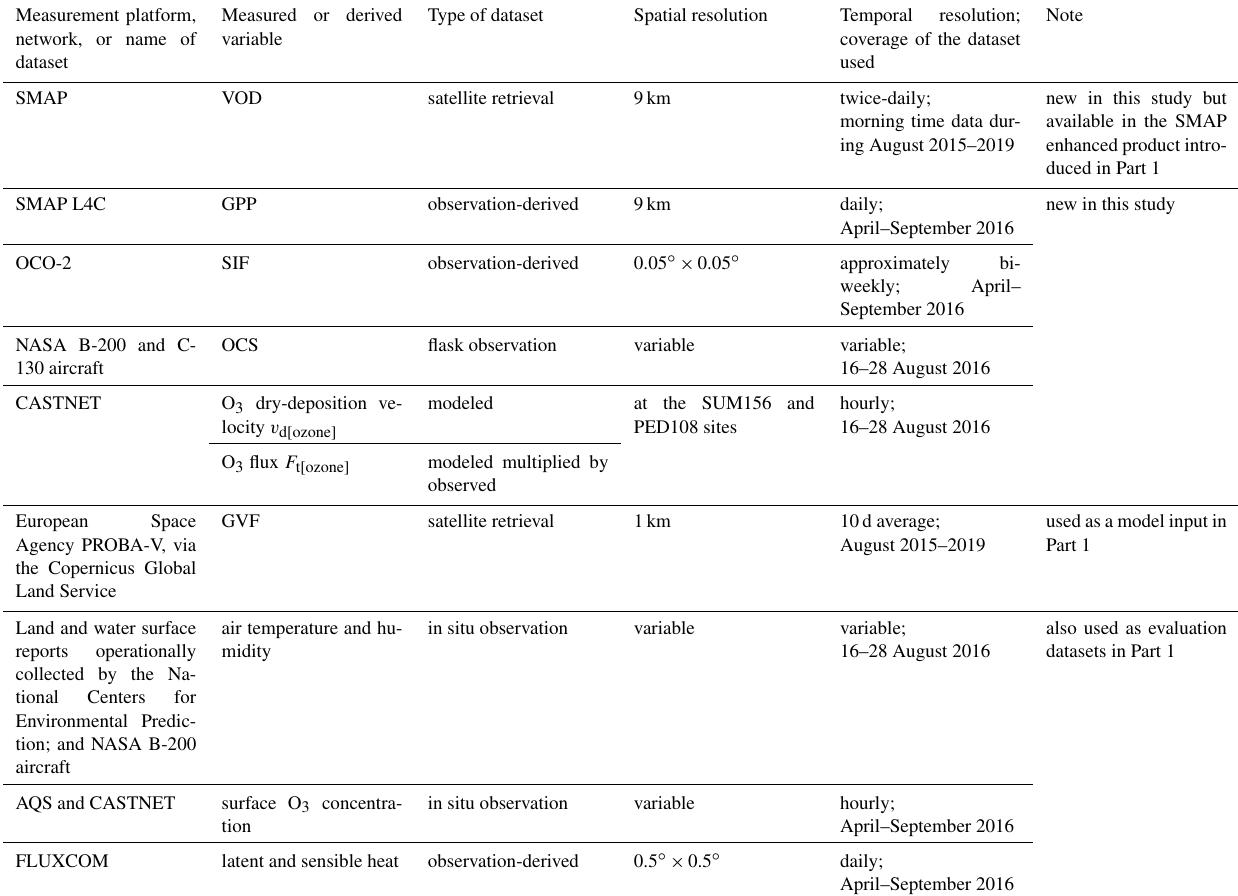
Table 2. Evaluation datasets relevant to this study, along with their key attributes. References of these products can be found in the “Data availability” section of this work and Huang et al. (2021).